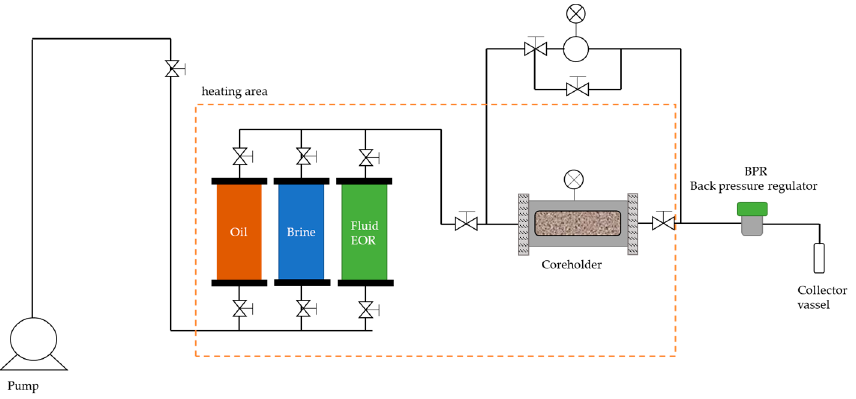
Figure 2. Core flooding experimental setup.